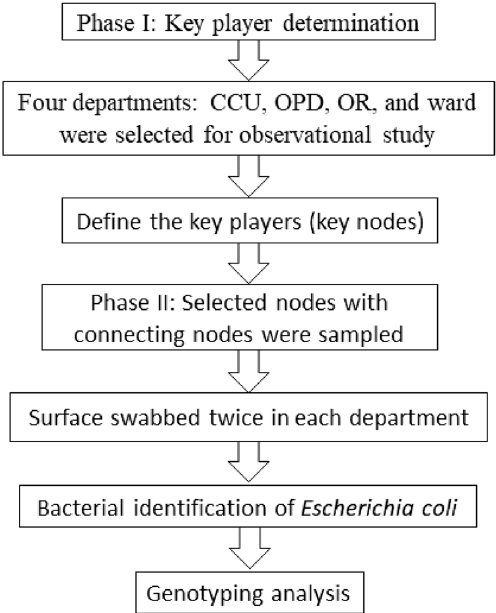
Figure 4. Flow chart of the research study. CCU critical care unit, OPD outpatient department, OR operation